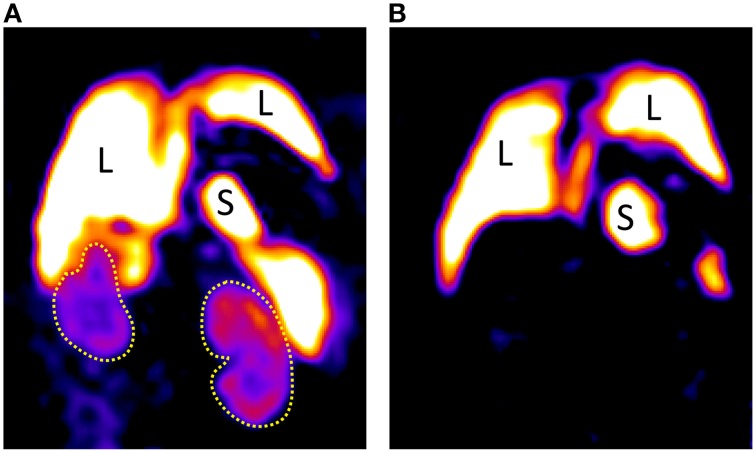
(A) Coronal 19F images of a mouse with ANCA-induced glomerulonephritis; 8 weeks after bone marrow transplantation showing extensive renal inflammatory cell infiltration, particularly in the cortex in comparison with a naïve mouse (B) showing a high signal in liver and spleen, but none in the kidneys. The low SNR of room temperature RF technology severely limits the spatial resolution achievable even at extended scan durations of almost 1 h. L indicates liver, S indicates spleen, and yellow dot lines depict kidneys. Data from Schreiber et al. (2013).